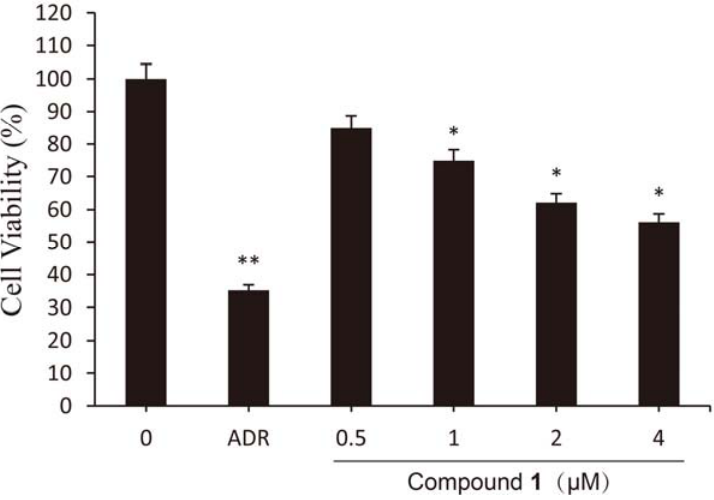
Figure 2. Viability of HCT-8 cells treated by compound 1 at different concentrations for 48 h. Results are expressed as mean ± SD (n = 3). * p < 0.05, ** p < 0.01, significantly different from the untreated